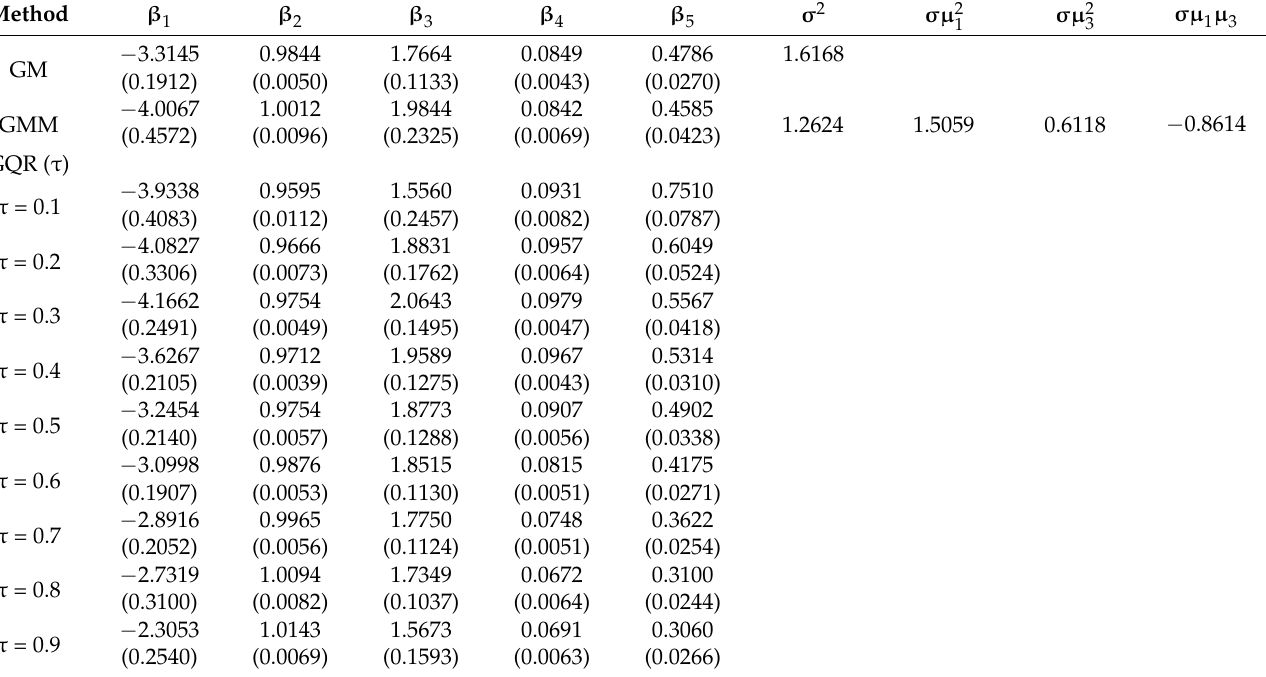
Table 3. Parameter estimates (standard error) for the generalized H–D model (GM), generalized nonlinear mixed effects model (GMM) and generalized nonlinear quantile regression (GQR) model at nine quantiles ( τ